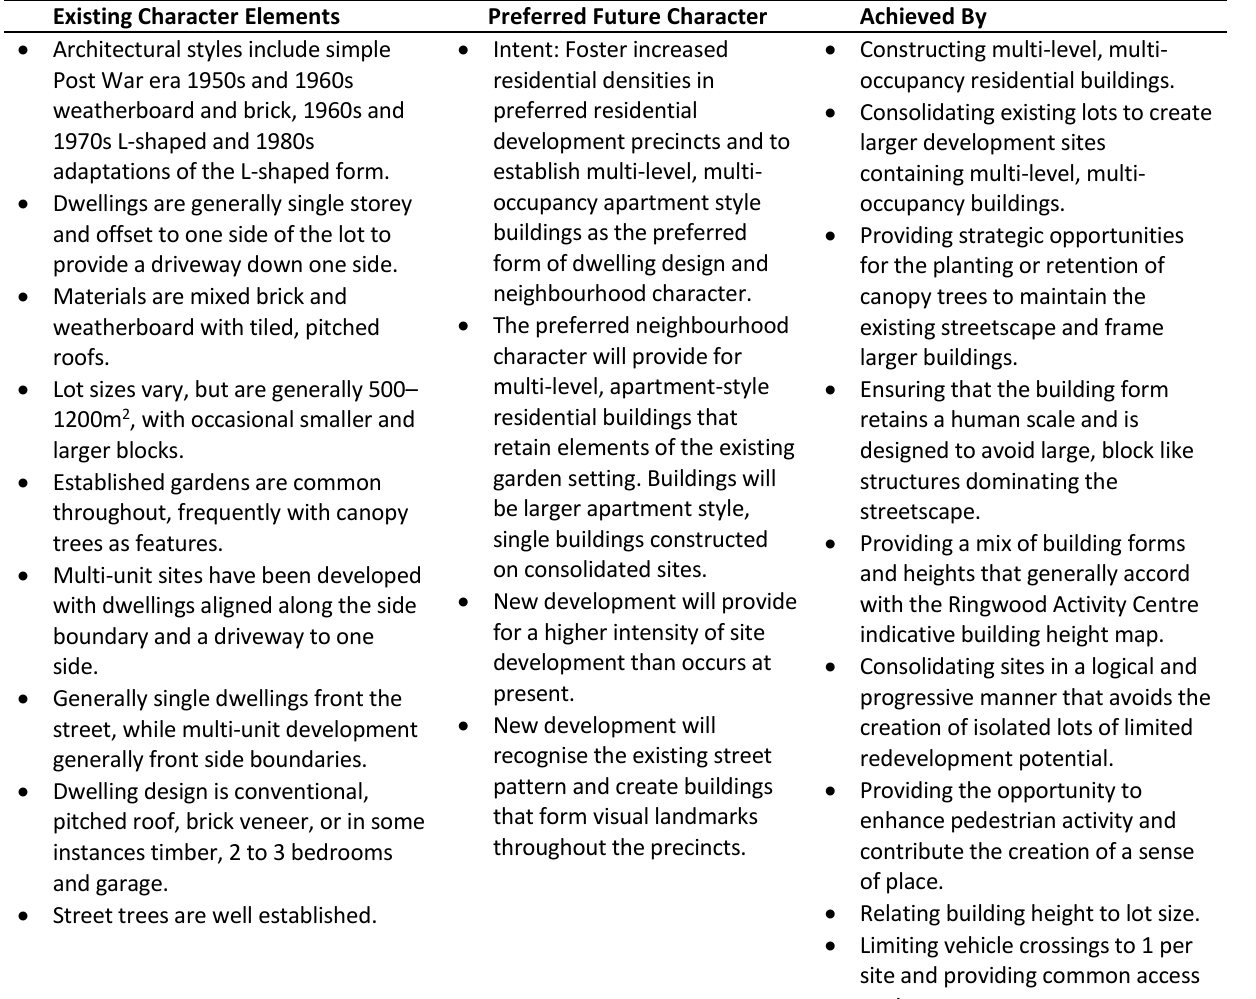
Table 2. Neighbourhood character statement and objectives for Ringwood Activity Centre (Maroondah City